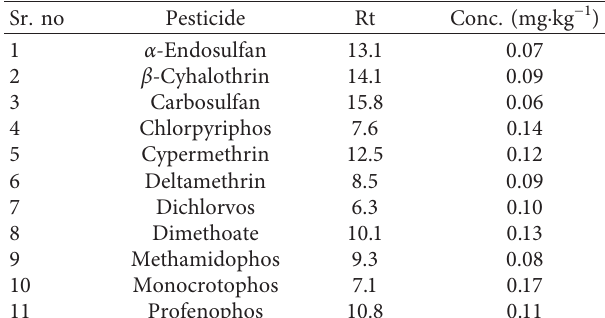
Figure 4: Concentration of organophosphorus pesticide residue in brinjal. Table 3: Pesticide residue found in brinjal samples in HPLC methods.